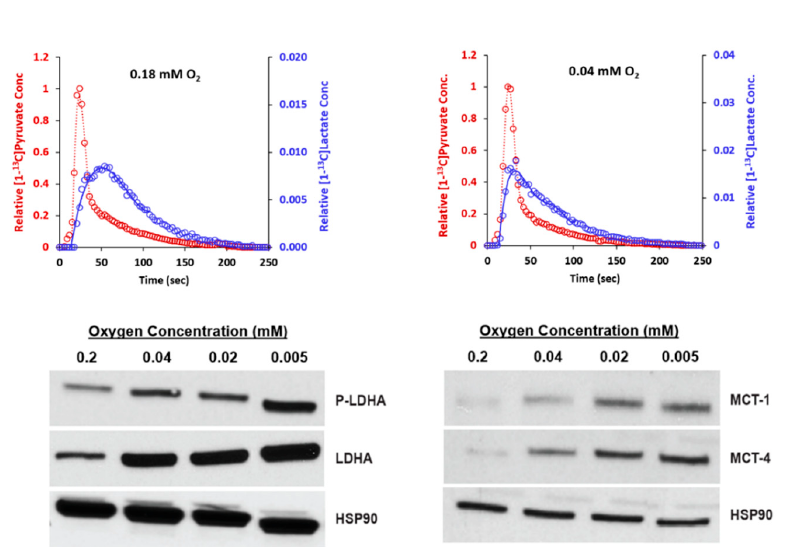
Figure 5. Conversion of hyperpolarized [1- 13 C]pyruvate to [1- 13 C]lactate is impacted by the oxygen level. At 0.18 mM oxygen, [1- 13 C]pyruvate is converted primarily to [1- 13 C]lactate; some is also converted to [1- 13 C]alanine (top stacked plot). The [1- 13 C]urea is a non-metabolic external standard. The blue spectrum below the stacked plot was acquired at the time of the highest level of lactate. Reducing the oxygen level to 0.04 mM produced a higher peak level of lactate (red spectrum). The normalized kinetic profiles for the two injections are shown below the spectra. The smoothed curves are least-square-fit sixth-order polynomials that were used to determine the TTP LP . At the bottom of the figure are Western blot results for cells grown at 4 different oxygen levels in 10 cm dishes (bottom). These demonstrate increases in LDHA, phosphorylated LDHA, MCT-1, and MCT-4 at reduced oxygen concentrations.